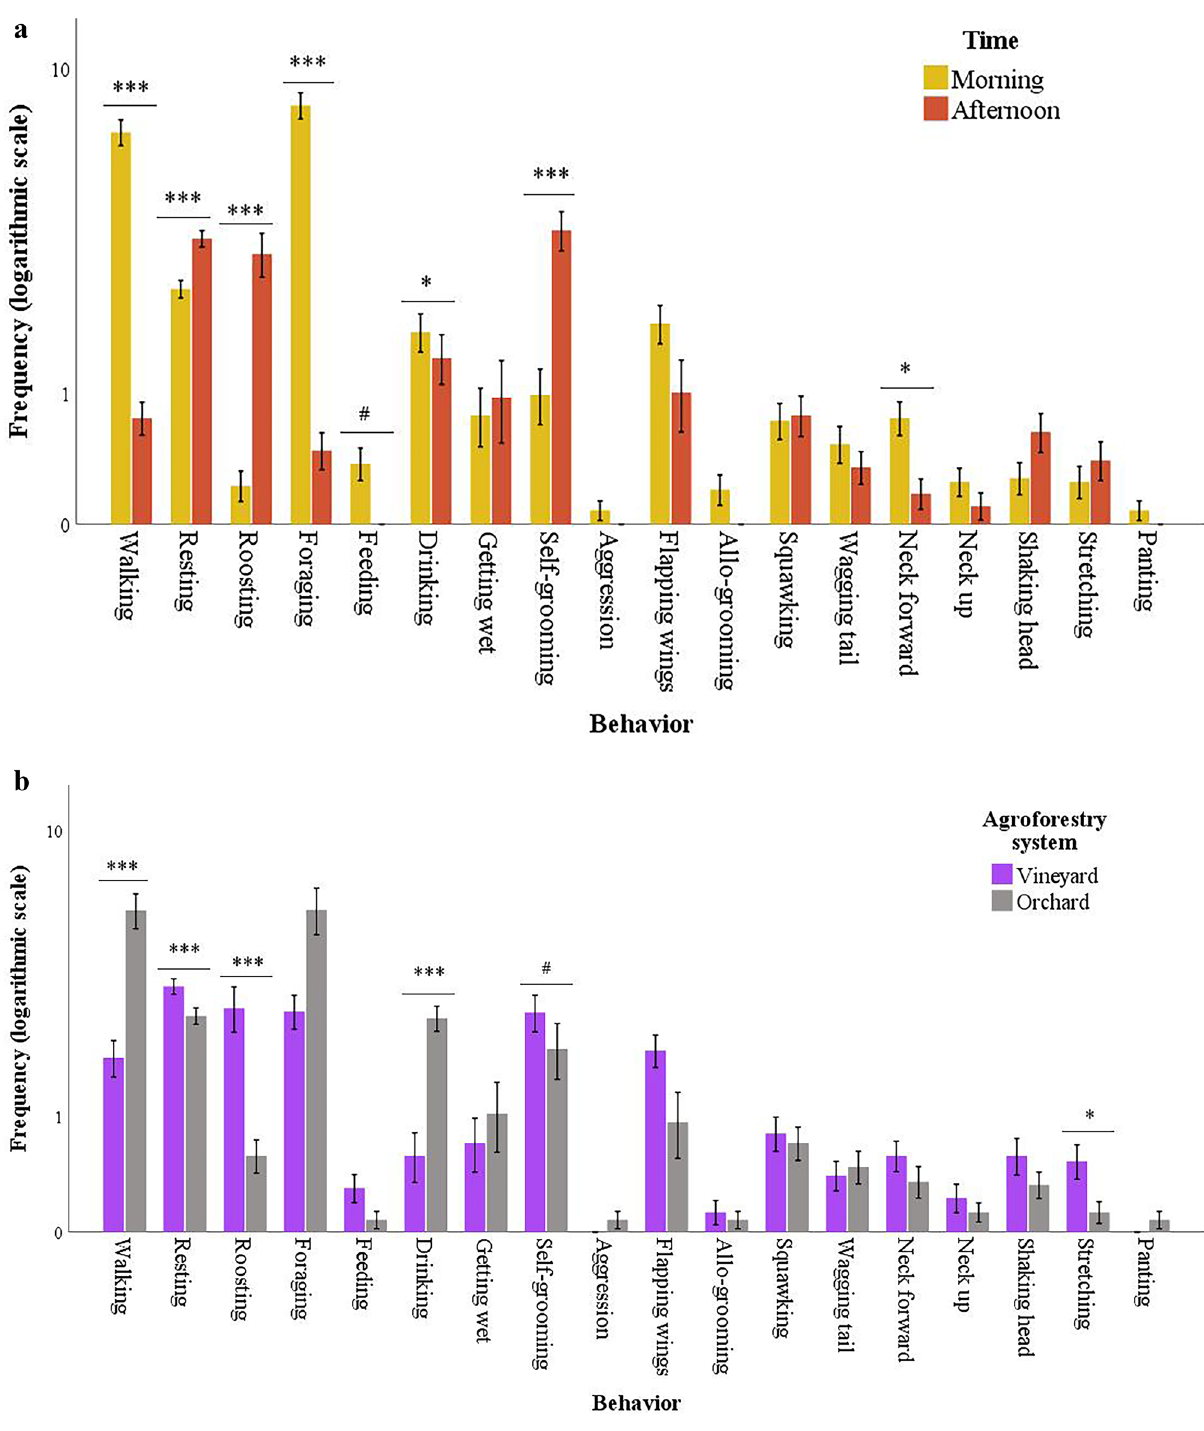
from models including the geese as subjects and time as a within-subject